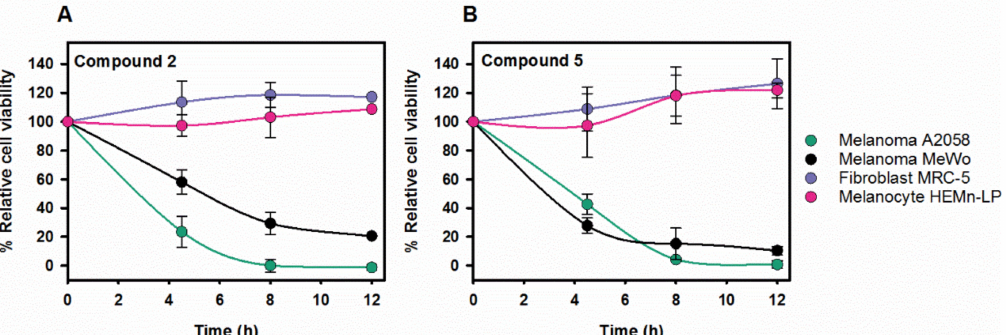
Figure 5. The selected compounds do not compromise the viability of melanocytes and fibroblasts whereas they are cytotoxic on melanoma cell lines. Time-dependence of the viability of the four cell lines after treatment with compounds 2 (40 µ M) ( A ) and 5 (20 µ M) ( B ). While melanoma cell viability decreased with time, neither fibroblasts nor melanocytes reduced their viability after 12 h. Following treatment, either XTT or Presto Blue were added, and the absorbance of samples was measured in a spectrophotometer after 4 or 2 h, respectively. Values are expressed as mean ± SD obtained from three independent experiments; 100% viability refers to each cell line without compound. Lines in panels A and B are to guide the